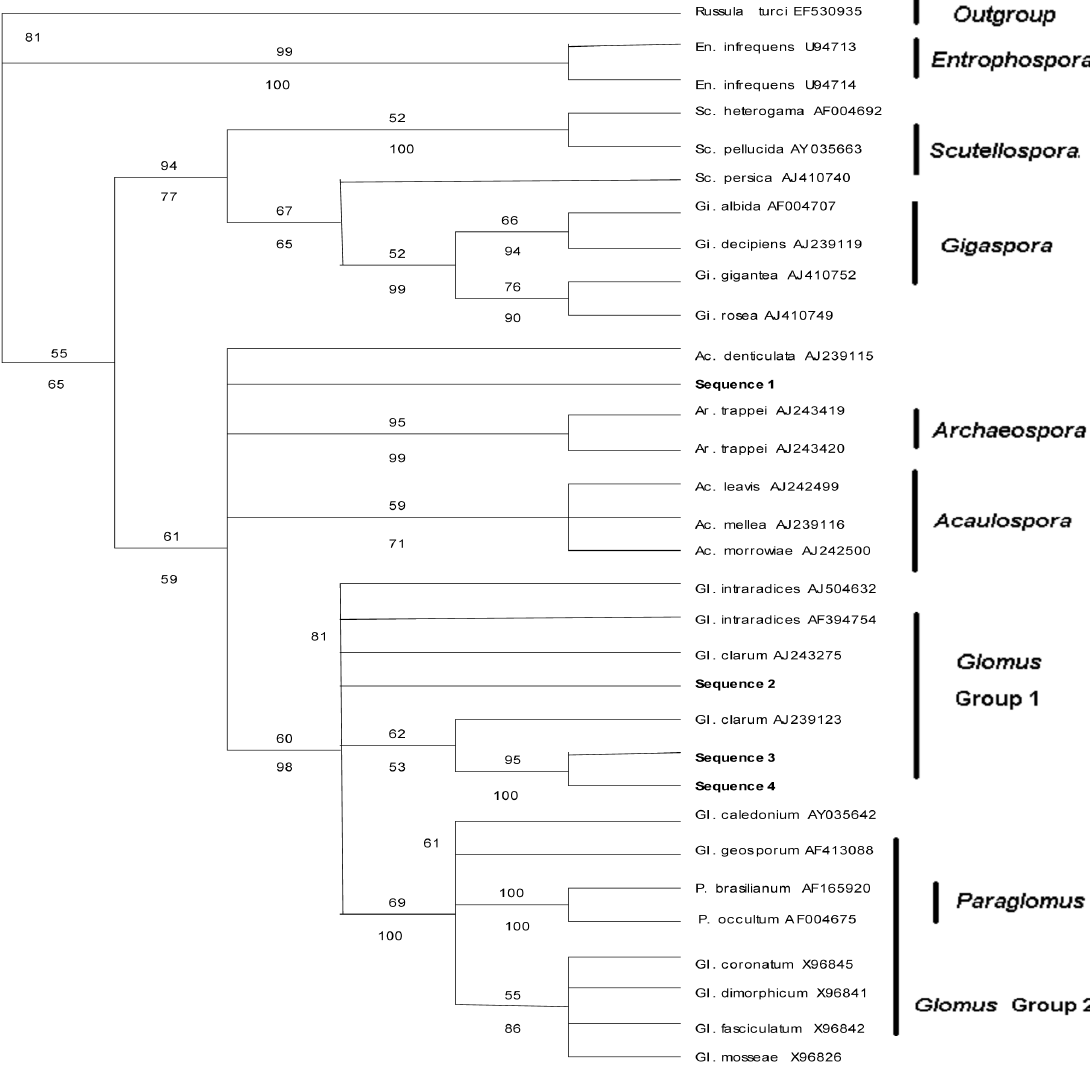
Fig. 6 . Maximum parsimony tree based on full length 5.8S nuclear rRNA gene sequences of the phylum Glomeromycota. Numbers above branches refer to bootstrap percentages. Numbers below branches are Bayesian posterior probability estimates, which are ex- pressed as percentages. Only bootstrap and posterior probability support over 50% are shown. The topology was rooted with Russula turci. Bold names are representatives of arbuscular mycorrhizal 5.8S nuclear rRNA gene sequences obtained during this study. Gen- Bank accession numbers are provided for sequences of known